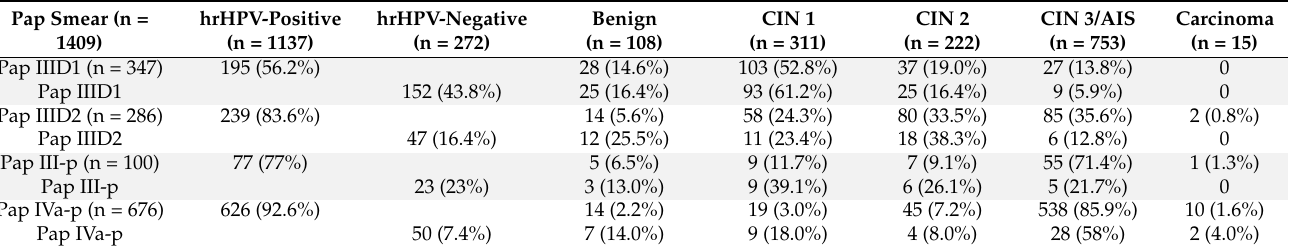
Table 3. Results for Pap IIID1, IIID2, III-p, and IVa-p in comparison the histologic results in women aged < 35.